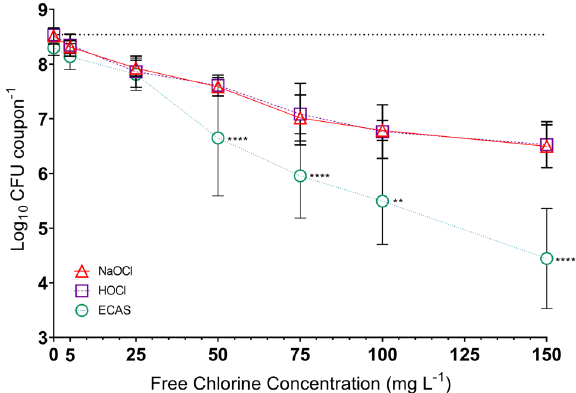
Fig. 4 Antimicrobial activity of NaOCl, ECAS and HOCl against Pseudomonas aeruginosa bio fi lms. Antimicrobial activity of NaOCl [ △ ], HOCl [ ▢ ] and ECAS [ ○ ] using standardised FC concentrations against Pseudomonas aeruginosa ATCC 15442 bio fi lms ( n = 9 ± s.d.). [ (cid:129)(cid:129)(cid:129) ] Refers to the recovered mean bio fi lm density (CFU coupon − 1 ) from control (untreated) treatment (0 mg L − 1 ); n = 18. Signi fi cant differences ( p -values) calculated through a two-way ANOVA with Tukey ’ s comparison post-test, with a con fi dence interval of 95% (**** p < 0.0001; ** p < 0.01). Error bars represent standard